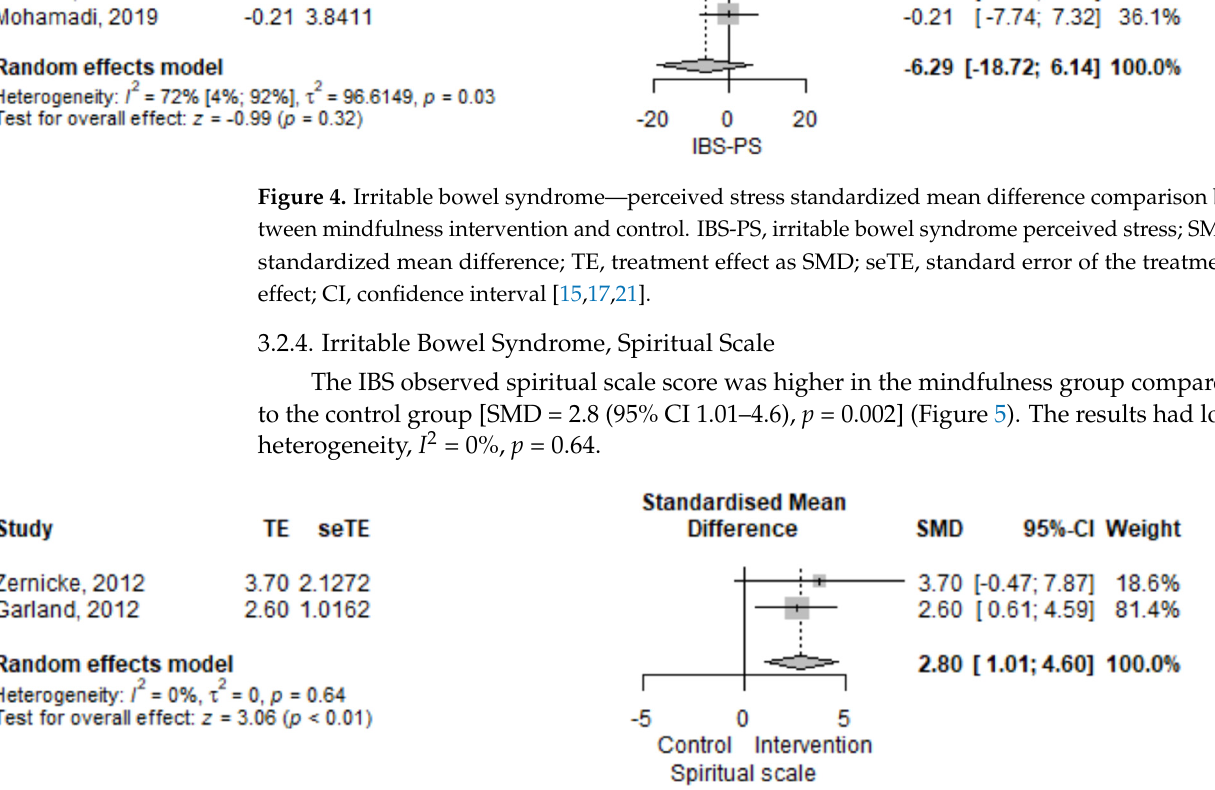
Figure 5. Irritable bowel syndrome the Functional Assessment of Chronic Illness Therapy—Spiritual Wellbeing Scale (FACIT-sp) standardized mean difference comparison between mindfulness intervention and control. SMD, standardized mean difference; TE, treatment effect as SMD; seTE, standard error of the treatment effect; CI, confidence interval [15,17].